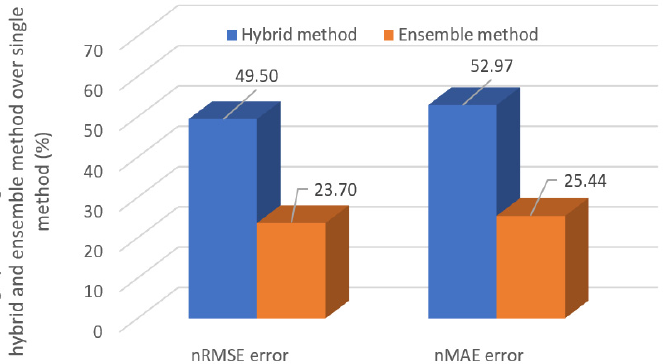
Figure 16. Average percentage improvement of the hybrids method and ensembles method relative to the single method for nRMSE and nMAE error metrics.